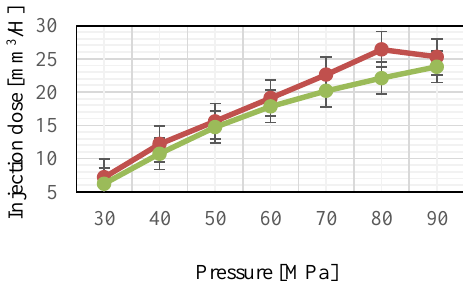
Fig. 7. Comparison of measured and calculated parameters for the injector control time of 675